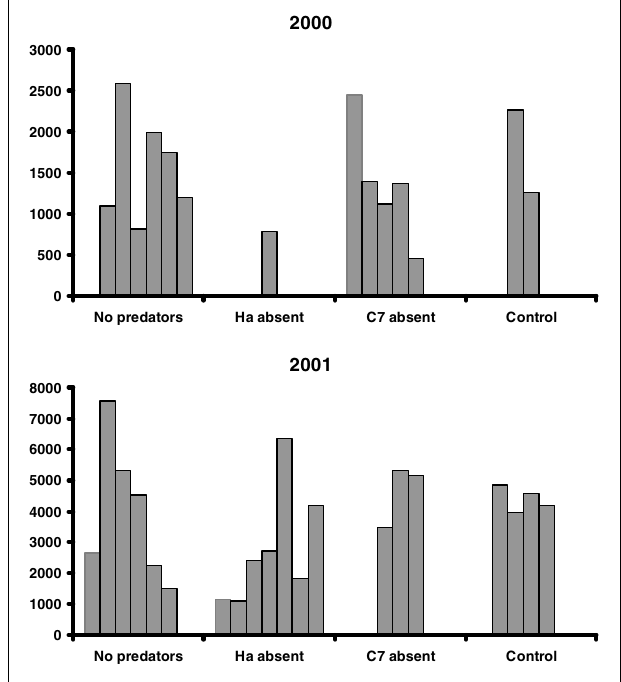
FIGURE 1 | Peak numbers of aphids per 15 leaves on shrubs from which eggs of all predators were removed (No predators), only C. septempunctata bruckii eggs and adults were removed (C7 absent), only H. axyridis eggs and adults were removed (Ha absent) and no eggs or adults were removed